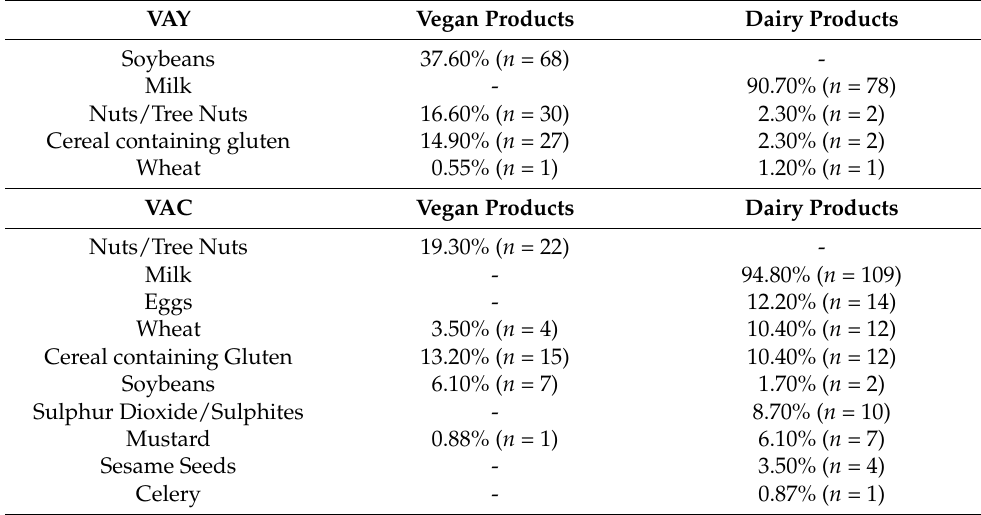
Table 4. List of allergen sources declared on yogurt and cheese and their vegan alternatives (VAY and VAC) launched in the EU market in